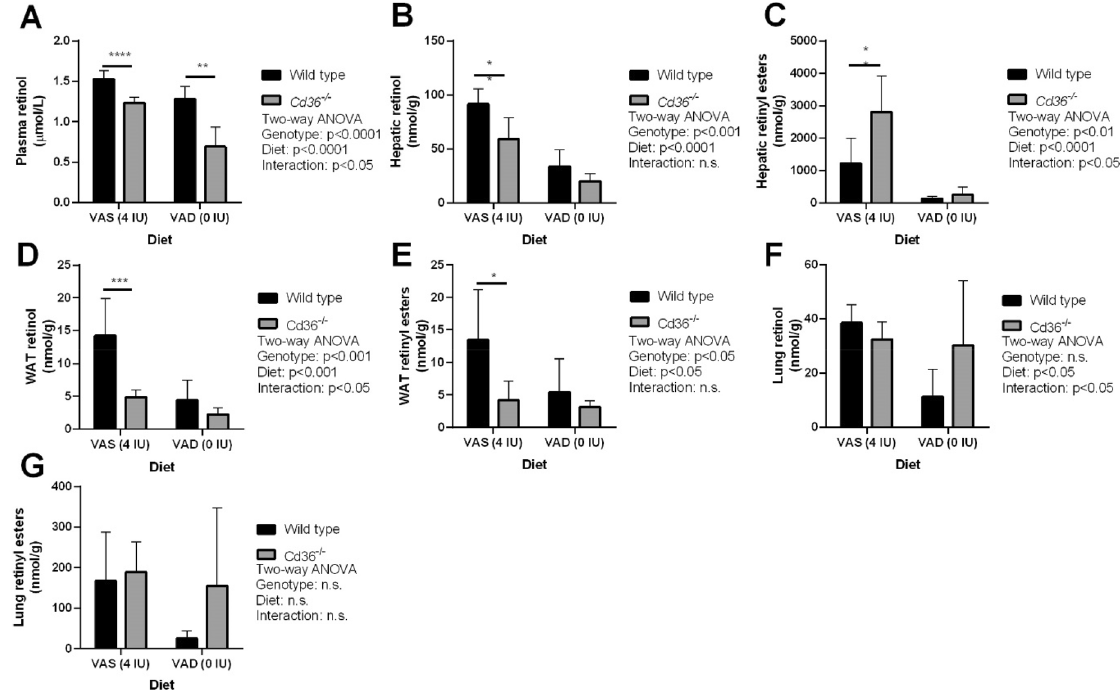
Figure 3. Tissue retinoid levels of wild type and Cd36 −/− mice on diets with varying vitamin A content. HPLC was used to determine tissue levels of ( A ) Plasma retinol, ( B ) Hepatic retinol, ( C ) Hepatic retinyl esters, ( D ) WAT retinol, ( E ) WAT retinyl esters, ( F ) Lung retinol, and ( G ) Lung retinyl esters in mice placed on a VAD diet from weaning. Tissue retinoid levels were normalized to volume of plasma ( A ) or tissue mass ( B – G ). Data is shown as mean ± S.D. and significance determined by two-way ANOVA (n = 6 per group). *p < 0.05, **p < 0.01, and ****p < 0.0001 denote a significant post-test result between genotypes within mice of the same age.